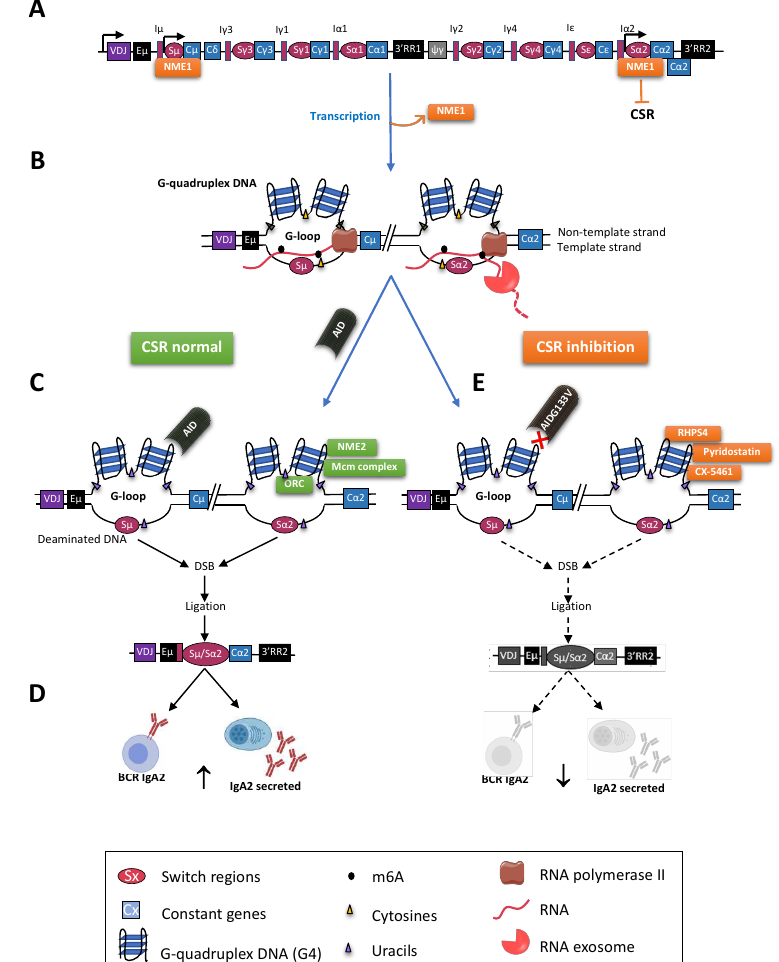
Figure 3. G4s and class switch recombination. ( A ) The human IgH locus is represented after VDJ recombination. The recombined VDJ gene and C H genes are represented by rectangles and the S regions by ovals. S regions are preceded by promoters and I exons. The human IgH locus also includes two regulatory 3′RR (black rectangles). Before CSR, NME1 binds to the S regions and prevents CSR; ( B ) Transcription through S regions by RNA Pol II (brown) yields noncoding RNA (purple). R-loops facilitate the formation of G4s (G-loops). Within loops, RNA:DNA hybrids restrict the accessibility of AID to only the nontemplate strand. The RNA exosome (orange) degrades the RNA hybridized to the template DNA strand, also exposing it to AID for DNA deamination; ( C ) After B cell activation, NME1 is removed, and AID binds G4s of targeted S regions, initiating breaks to be repaired by ligation of distant S regions (here, Sµ and Sα2). AID targets cytosines ( C ) on accessible ssDNA. CSR is modulated by natural G4s ligands, such as NME2, which bind to G4s after transcription and stimulation, and also by the ORC and the Mcm complexes; ( D ) CSR diversifies the functions of B cells and of class-switched antibodies (here IgA2); ( E ) CSR can be inhibited by chemicals ligands of G4s, such as RHPS4, pyridostatin, and CX-5461, decreasing the frequency of B cells expressing or secreting class-switched Ig.